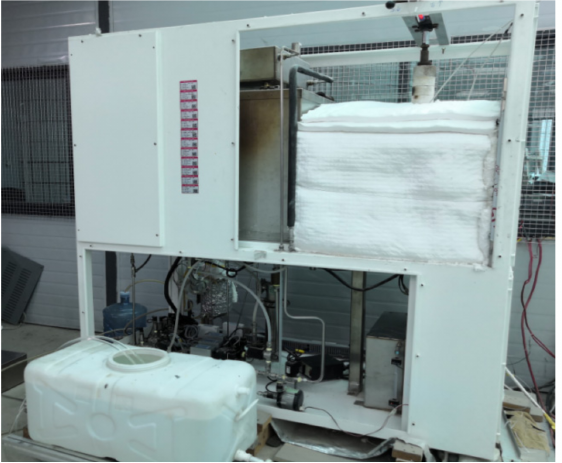
Figure 2. Physical diagram of SOFC system.